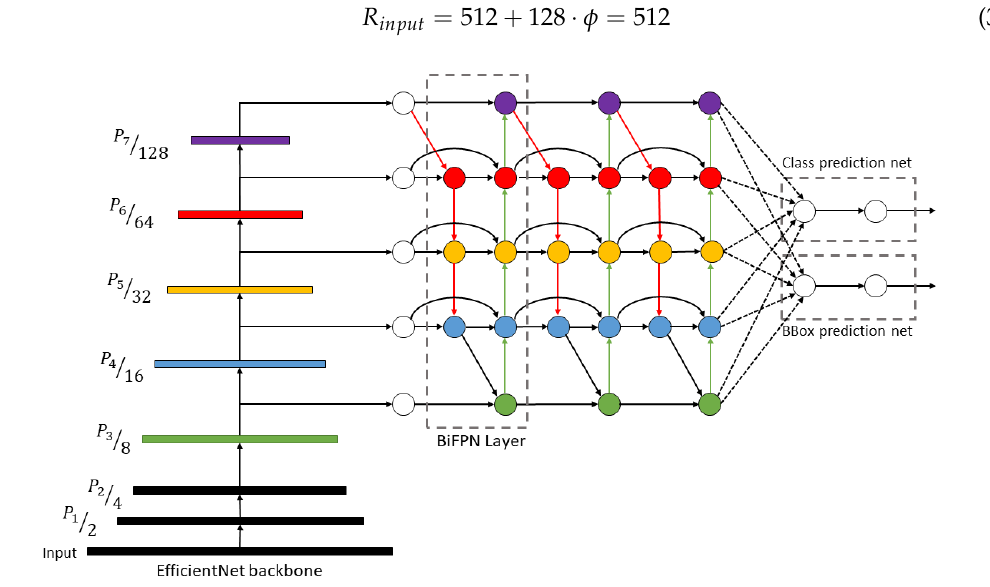
Figure 3. EfficientDet-D0 architecture. EfficientNet-B0 [34] is the backbone network; multiple BiFPN layers are the feature network and the class/box prediction network. The class and box prediction layers are repeated as many times as there are classes; in this work, the authors used just the class box